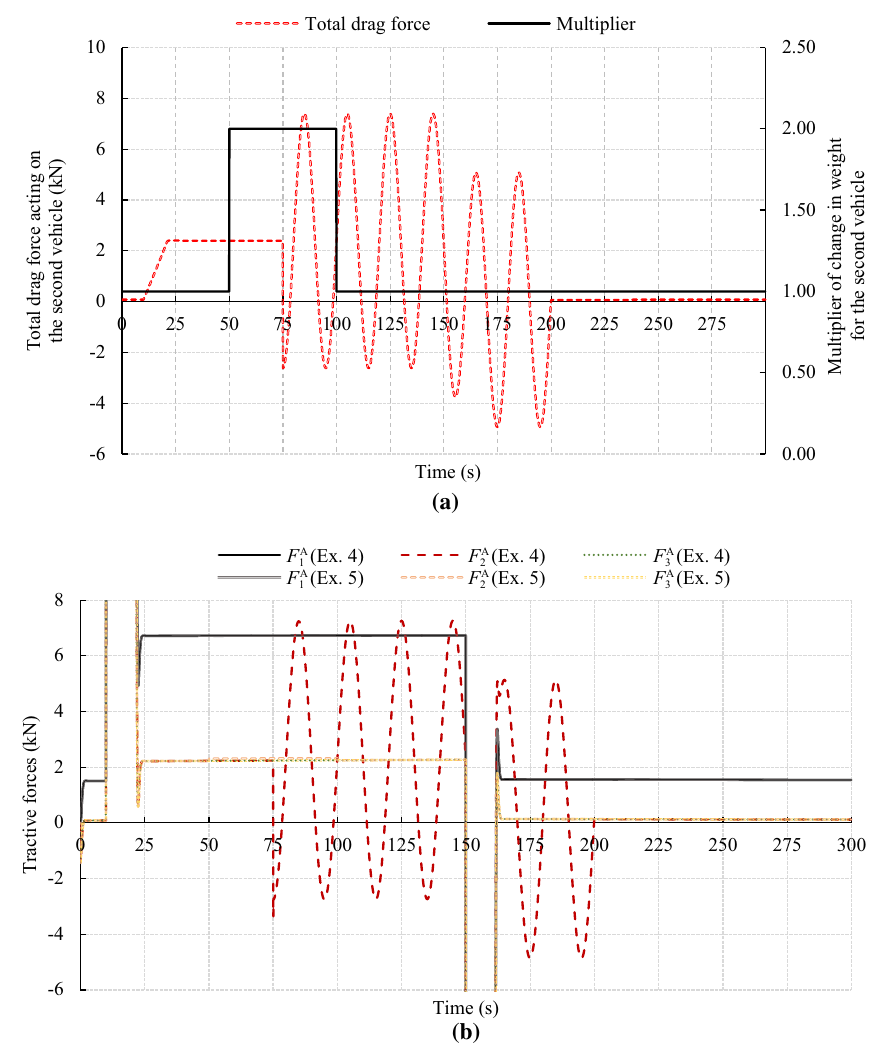
Fig. 9 Analysis of the slave control systems. a Time course of the variability of external disturbances acting on the second carriage of the MUT; b compensating action of tractive forces during active vibration